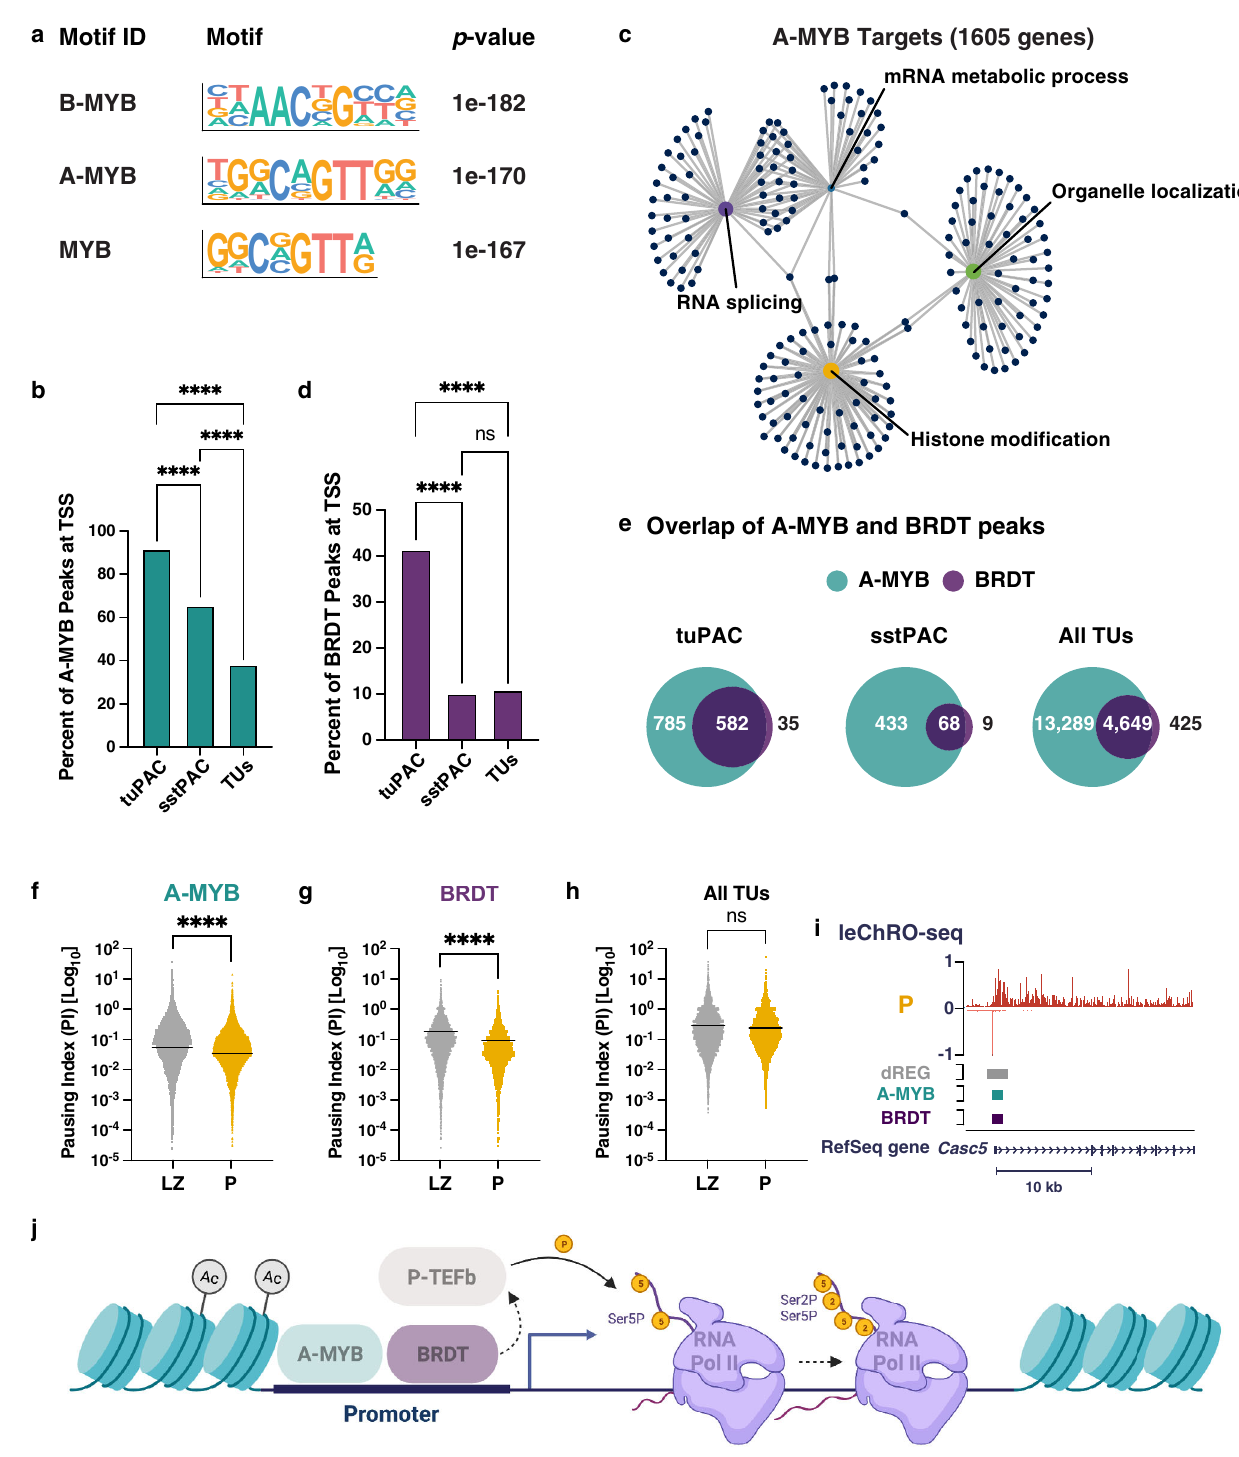
pachytene and diplotene spermatocytes from JQ1-treated mice when compared to control spermatocytes (**** p -value <0.0001; Fig. 5b,